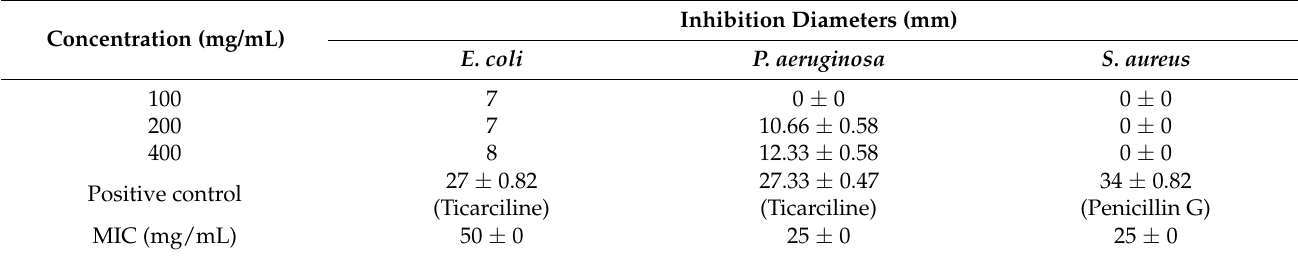
Table 3. Antibacterial activity of the methanolic extract from E. spinosissimus